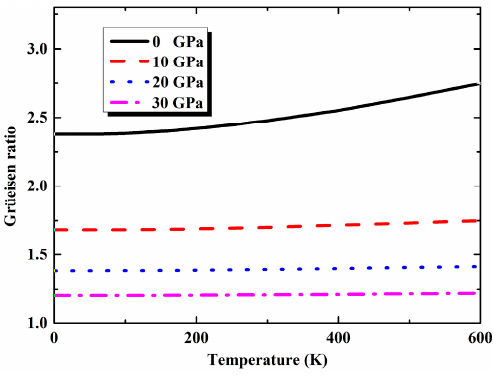
Figure 5. The calculated variation of Grüneisen parameters of K 8 Si 46 with temperature under 0, 10, 20 and 30 GPa.